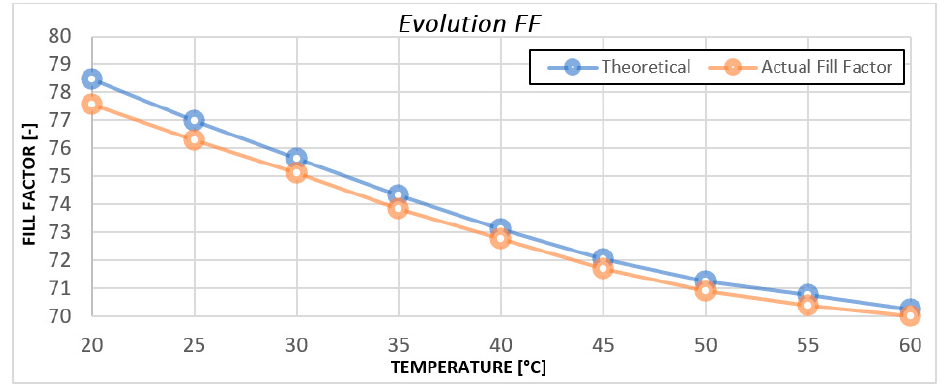
Figure 8. Plot representation of the temperature influence to the FF characteristics of the PV gener- ator.